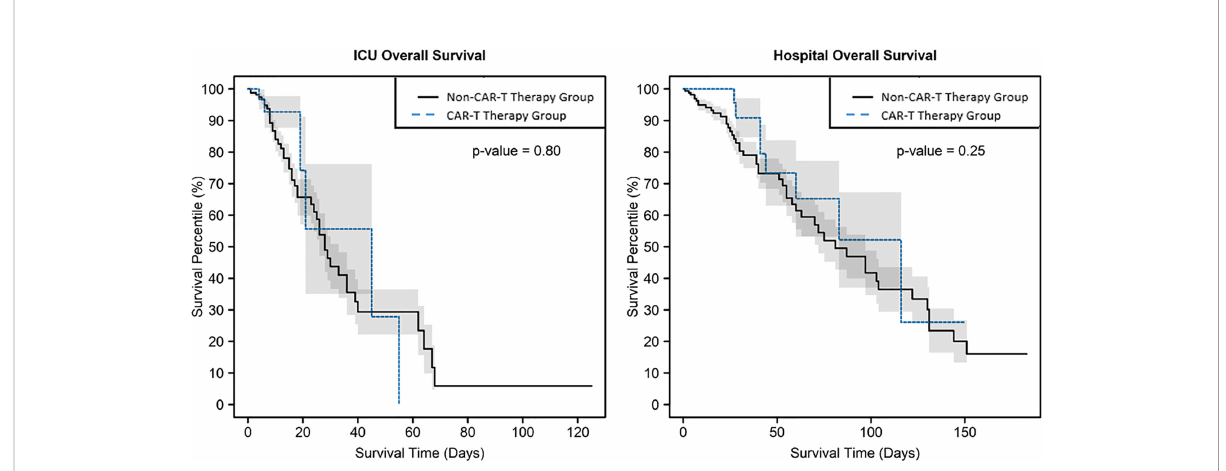
FIGURE 1 Kaplan – Meier survival curves, which account for mortality over time, with shaded +/- standard error, showed no evidence of difference by CAR- T therapy group in intensive care unit mortality or hospital mortality, with p = 0.80 and 0.25,